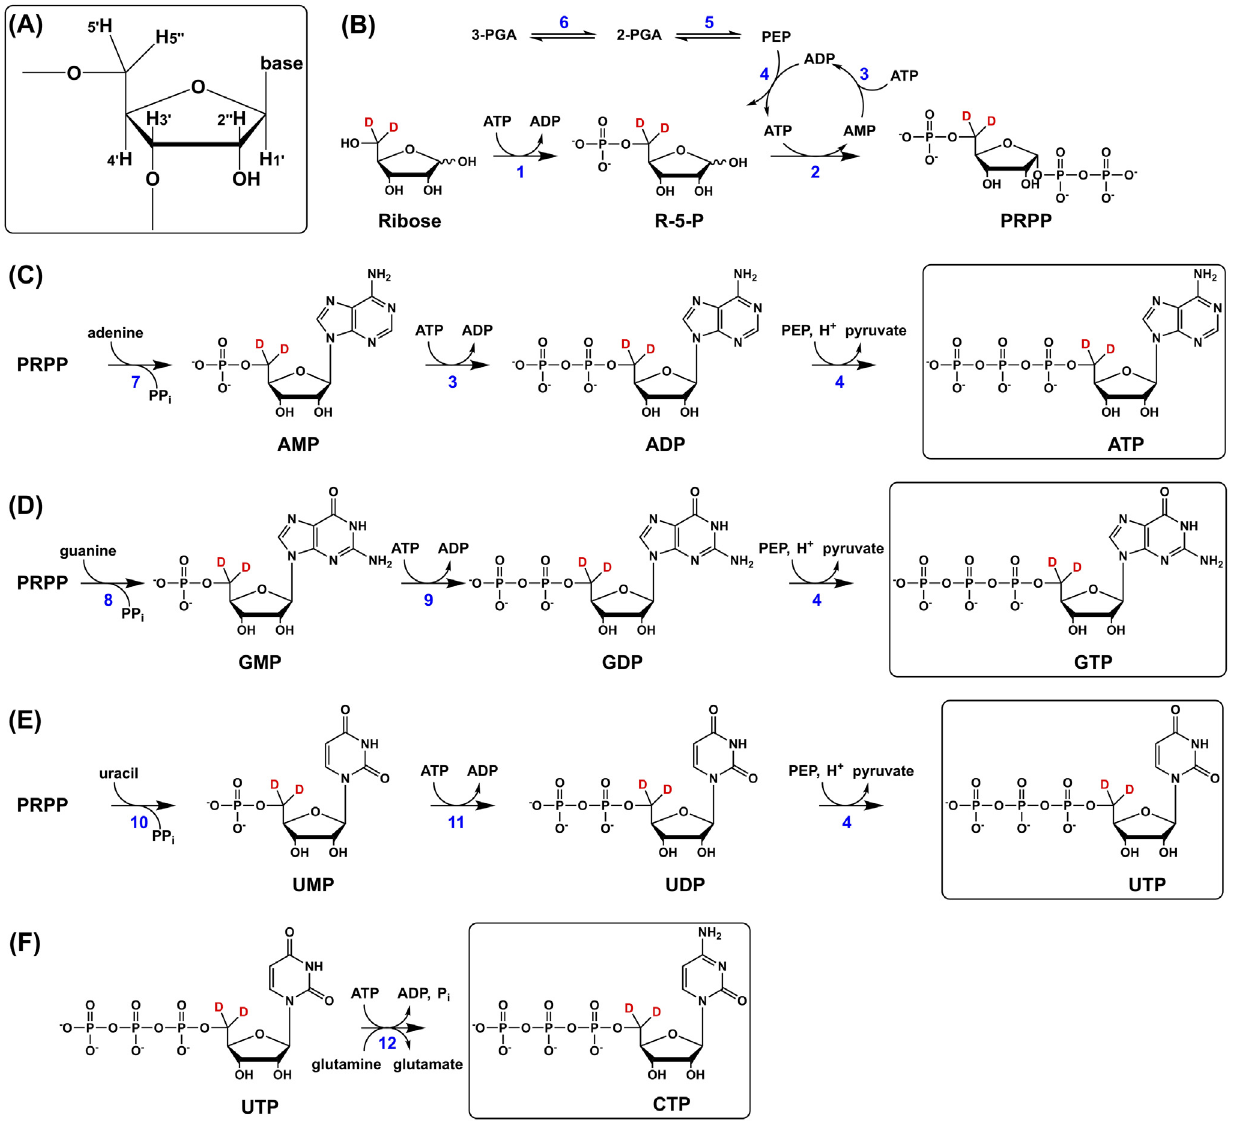
Figure 1. (A) Numbering convention for ribose hydrogens. (B) Formation of [5 ′ ,5 ″ - 2 H]PRPP from labeled D -ribose. (C – E) Synthesis of 5 ′ -dideuterated ATP, GTP, and UTP from PRPP. (F) Conversion of 5 ′ -dideuterated UTP to 5 ′ -dideuterated CTP. Enzymes are (1) ribokinase, (2) PRPP synthetase, (3) myokinase, (4) PK, (5) enolase, (6) 3-phosphoglycerate mutase, (7) APRT, (8) XGPRT, (9) guanylate kinase, (10) UPRT, (11) NMPK, and (12) CTPS. Deuterium is colored red. This scheme adapted from Figure 3 in Tolbert et al.